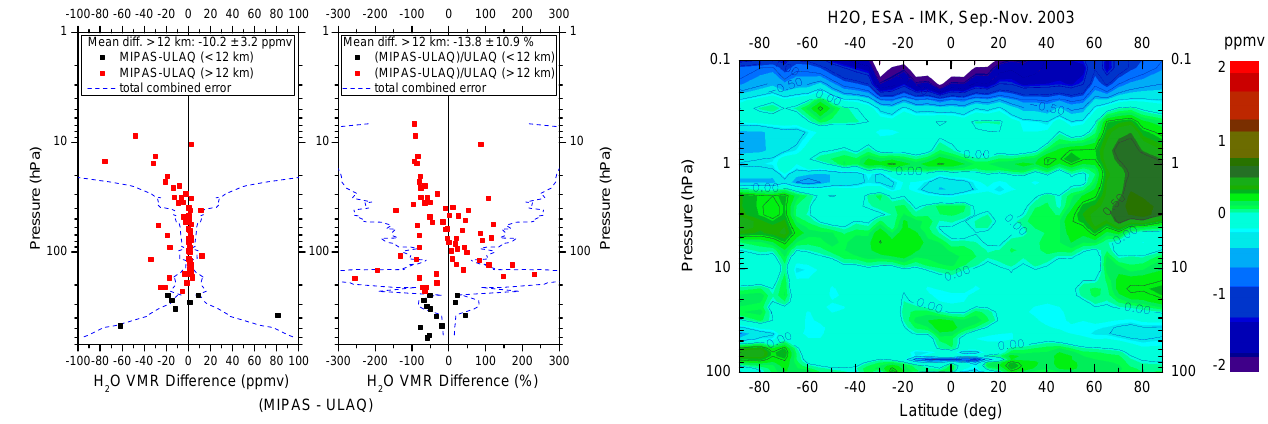
Fig. 20. Difference of global zonally averaged H 2 O VMR distributions in the 100hPa to 0.1 hPa altitude range as retrieved by the ESA and IMK/IAA processors for the Sept. to Nov. 2003 period. Differences are mostly within 0.25 ppmv (or about 10%) except of the Arctic upper stratosphere and towards the upper boundary of the MIPAS measurement range. Reddish colours denote positive and bluish colours negative deviations.